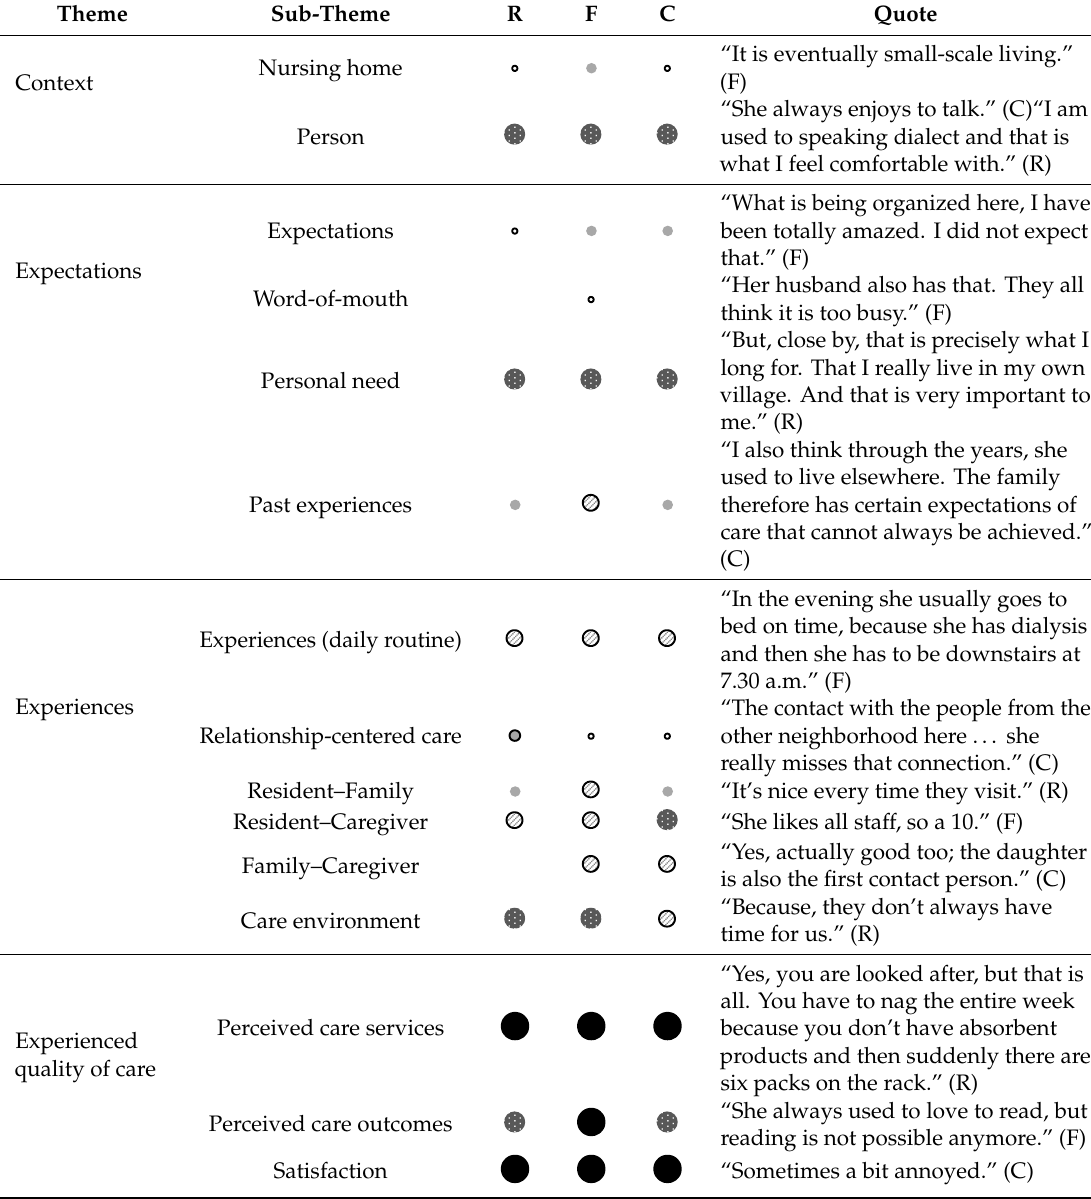
Table 5. Connecting Conversations content validity coded with INDEXQUAL themes.